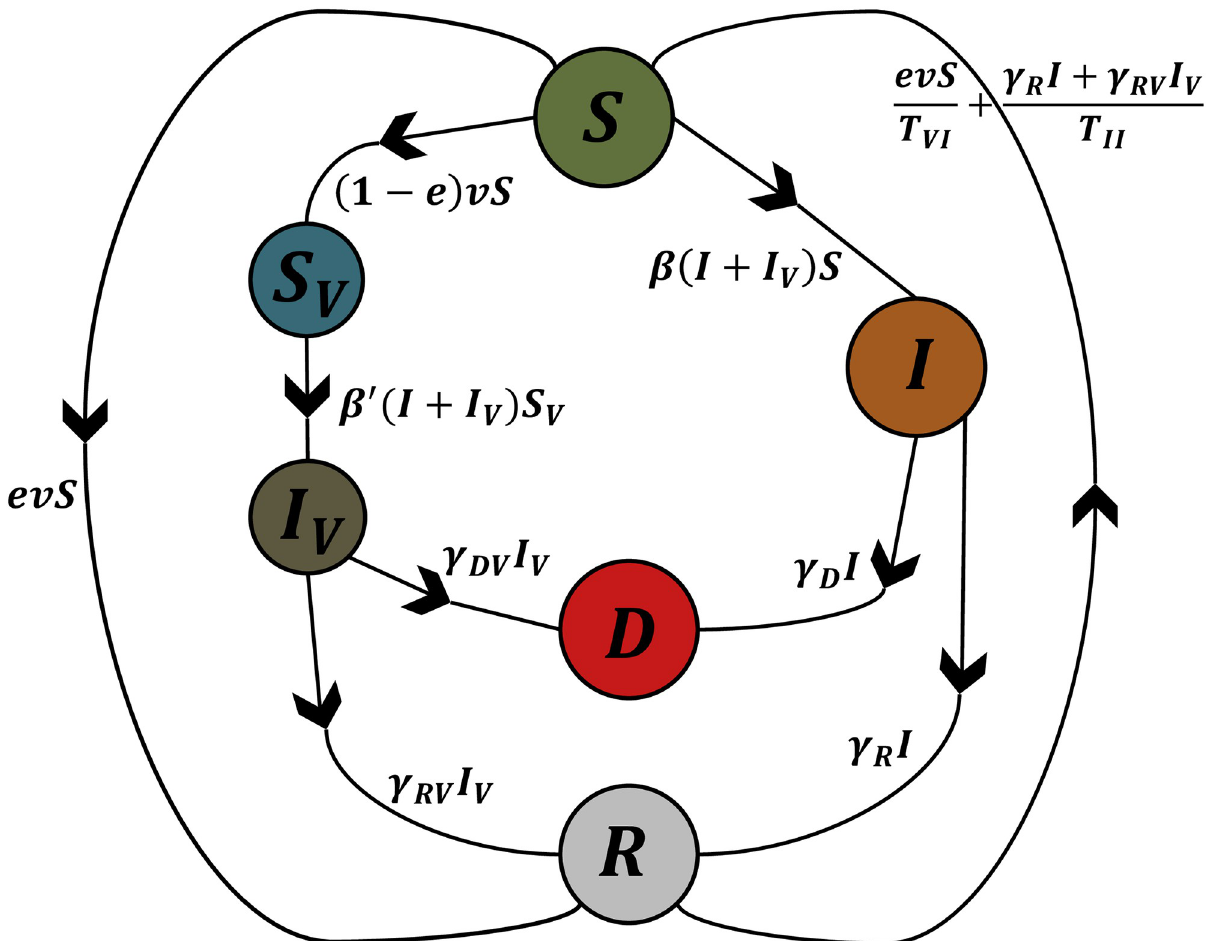
Fig 1. A schematic diagram of the SS model showing the six compartments of the model (susceptible, vaccinated susceptible, infectious, V II V RD vaccinated infectious, recovered and dead) together with their transfer dynamics and the coefficients relating transfers among different